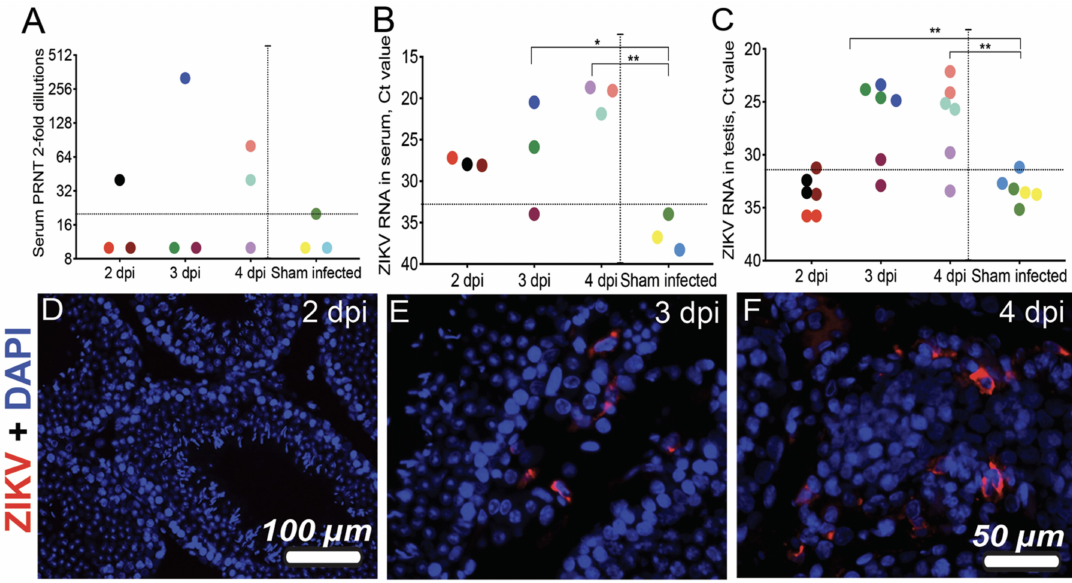
Figure 1. Defining Zika virus (ZIKV) infection on STAT2 KO hamsters during acute infection. Serum PRNT ( A ), ZIKV RNA titers in serum ( B ) and testes (Ct values) ( C ), and immunohistochemistry of ZIKV antigens in testes at 2, 3, and 4 dpi ( D – F ). Three animals were processed for each time point ( A – C ). Tissues from both right and left testes were processed for RT-PCR (C) and representative IHC images are shown with ZIKV infection ( D – F ). **, p < 0.005 by one-way ANOVA, sham infection compared with ZIKV infection. Horizonal dashed lines designate limit of detection in Figure 1A–C based on sham infection; vertical dashed lines separate infected animals from sham infected ones. Each of the animals were color-coded in A – C